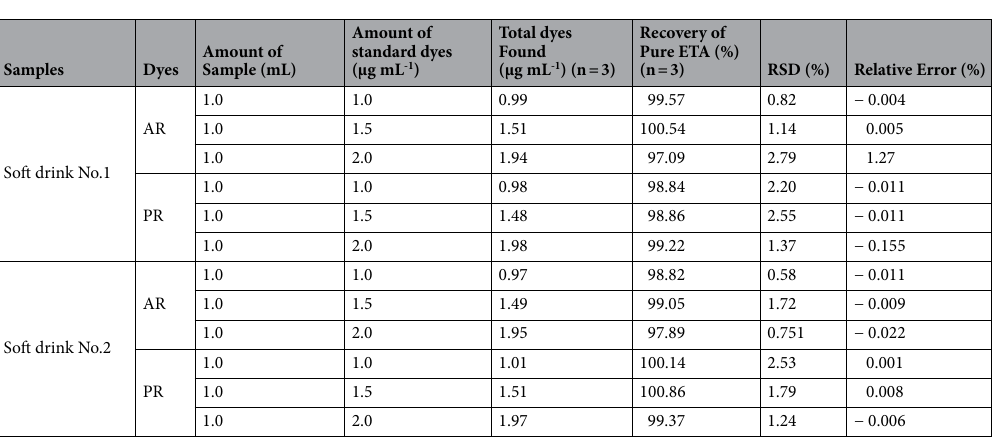
Table 1. Determination of Dyes in soft drinks by Standard addition method.